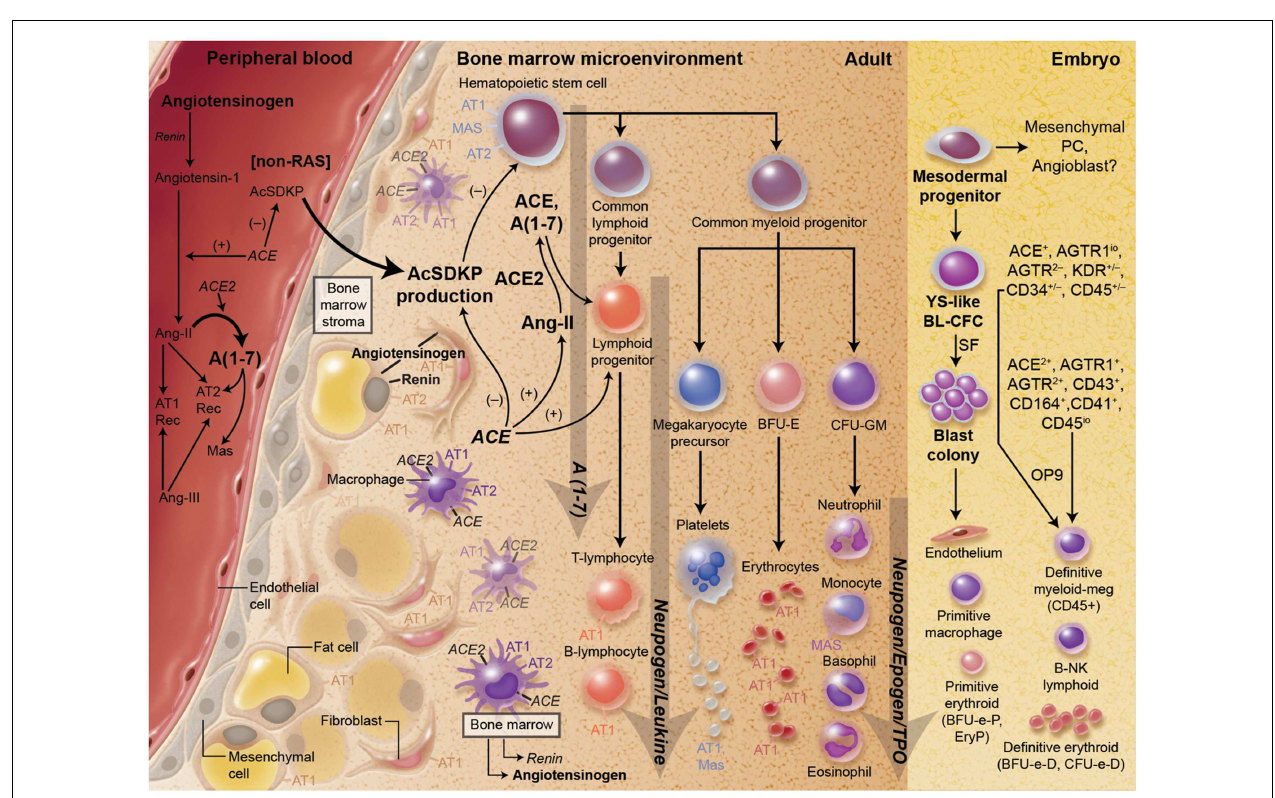
FIGURE 1 |There is substantial evidence for a key role for the RAS both primitive and definitive hematopoiesis as well as the development of hematopoietic progenitor cells . Every component of the RAS is present in the local environment of the bone marrow.